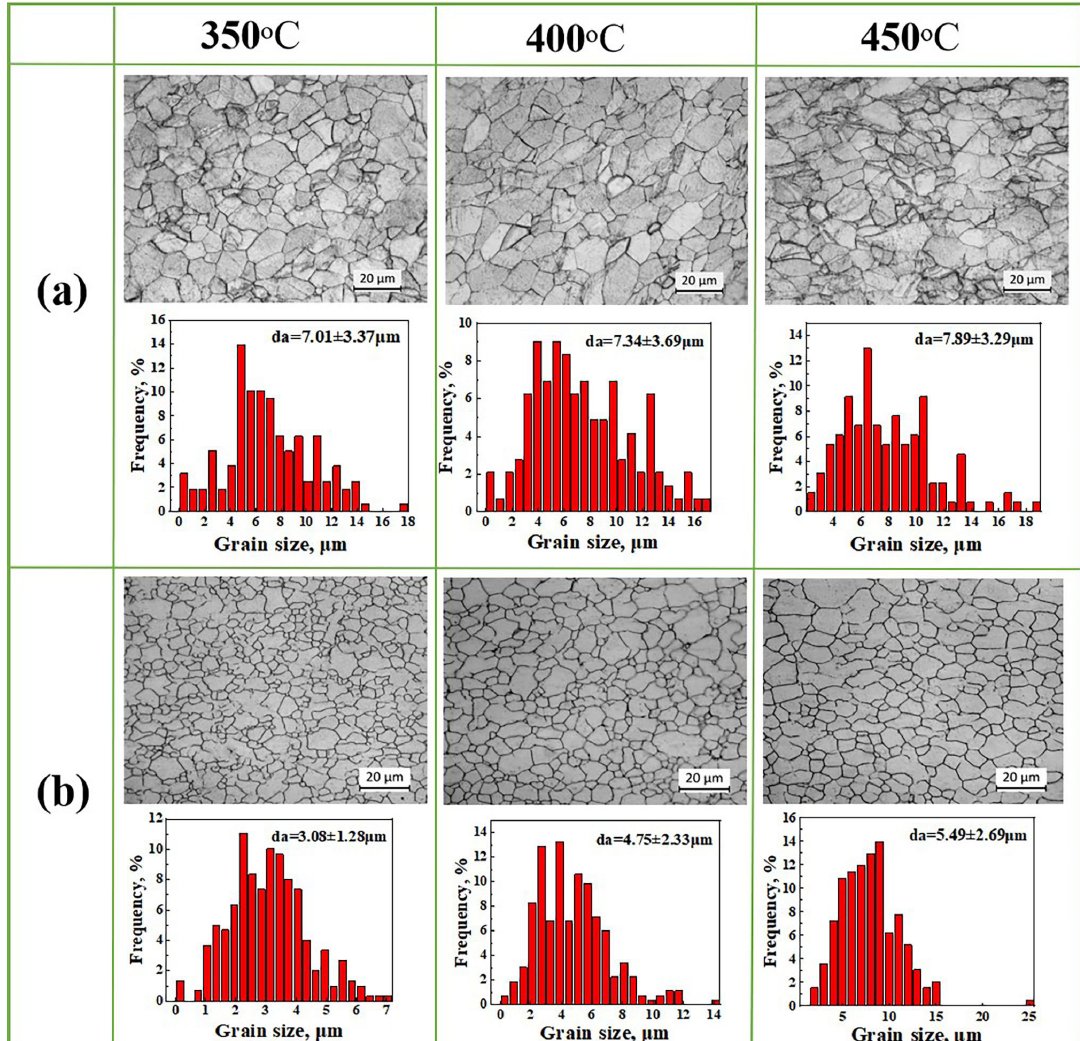
Figure 7. Metallographic structure and grain size distribution of (a) Ti and (b) Mg at different hot-pressing